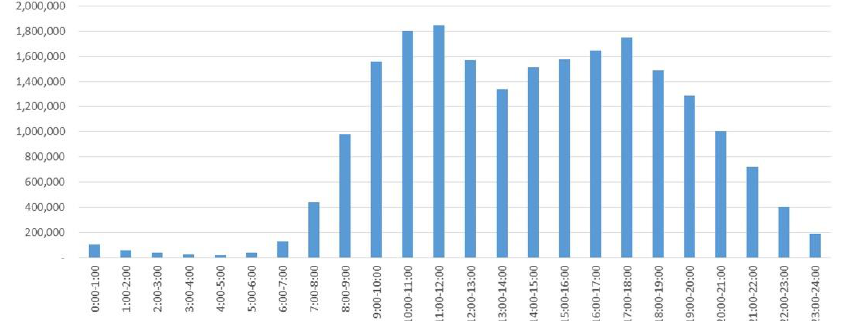
Figure 14. Cellular signaling data week distribution.